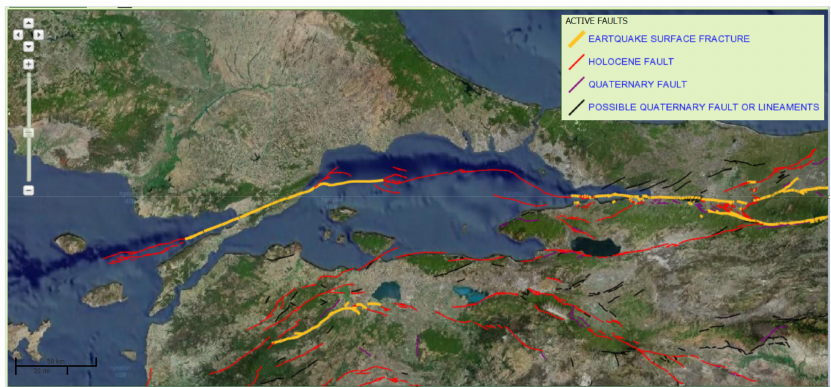
Figure 7. Regional active fault characterization by [49].